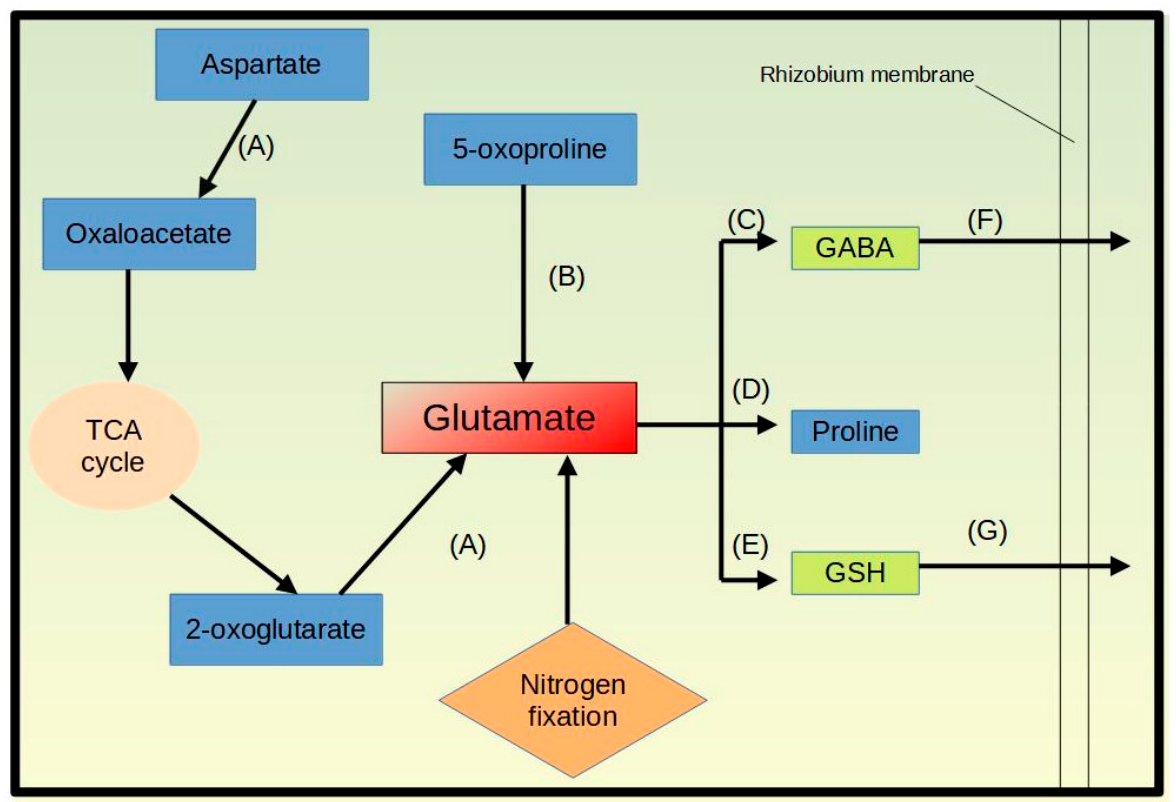
Figure 6. A schematic flow showing glutamate metabolic pathways in bacteroids under salinity stress. The letters represent the enzymes ( A ) aspartate amino transferase (K14454, COG0075), ( B ) 5-oxoprolinase (K01469), ( C ) glutamate decarboxylase 1 (K01580), ( D ) gamma-glutamyl phosphate reductase (COG0014), ( E ) glutathione synthase (K01920), ( F ) branched-chain amino acid transport system substrate-binding protein (K01999), and ( G ) glutathione transport system substrate-binding protein (K13889). This figure was drawn in Libre Office Draw.